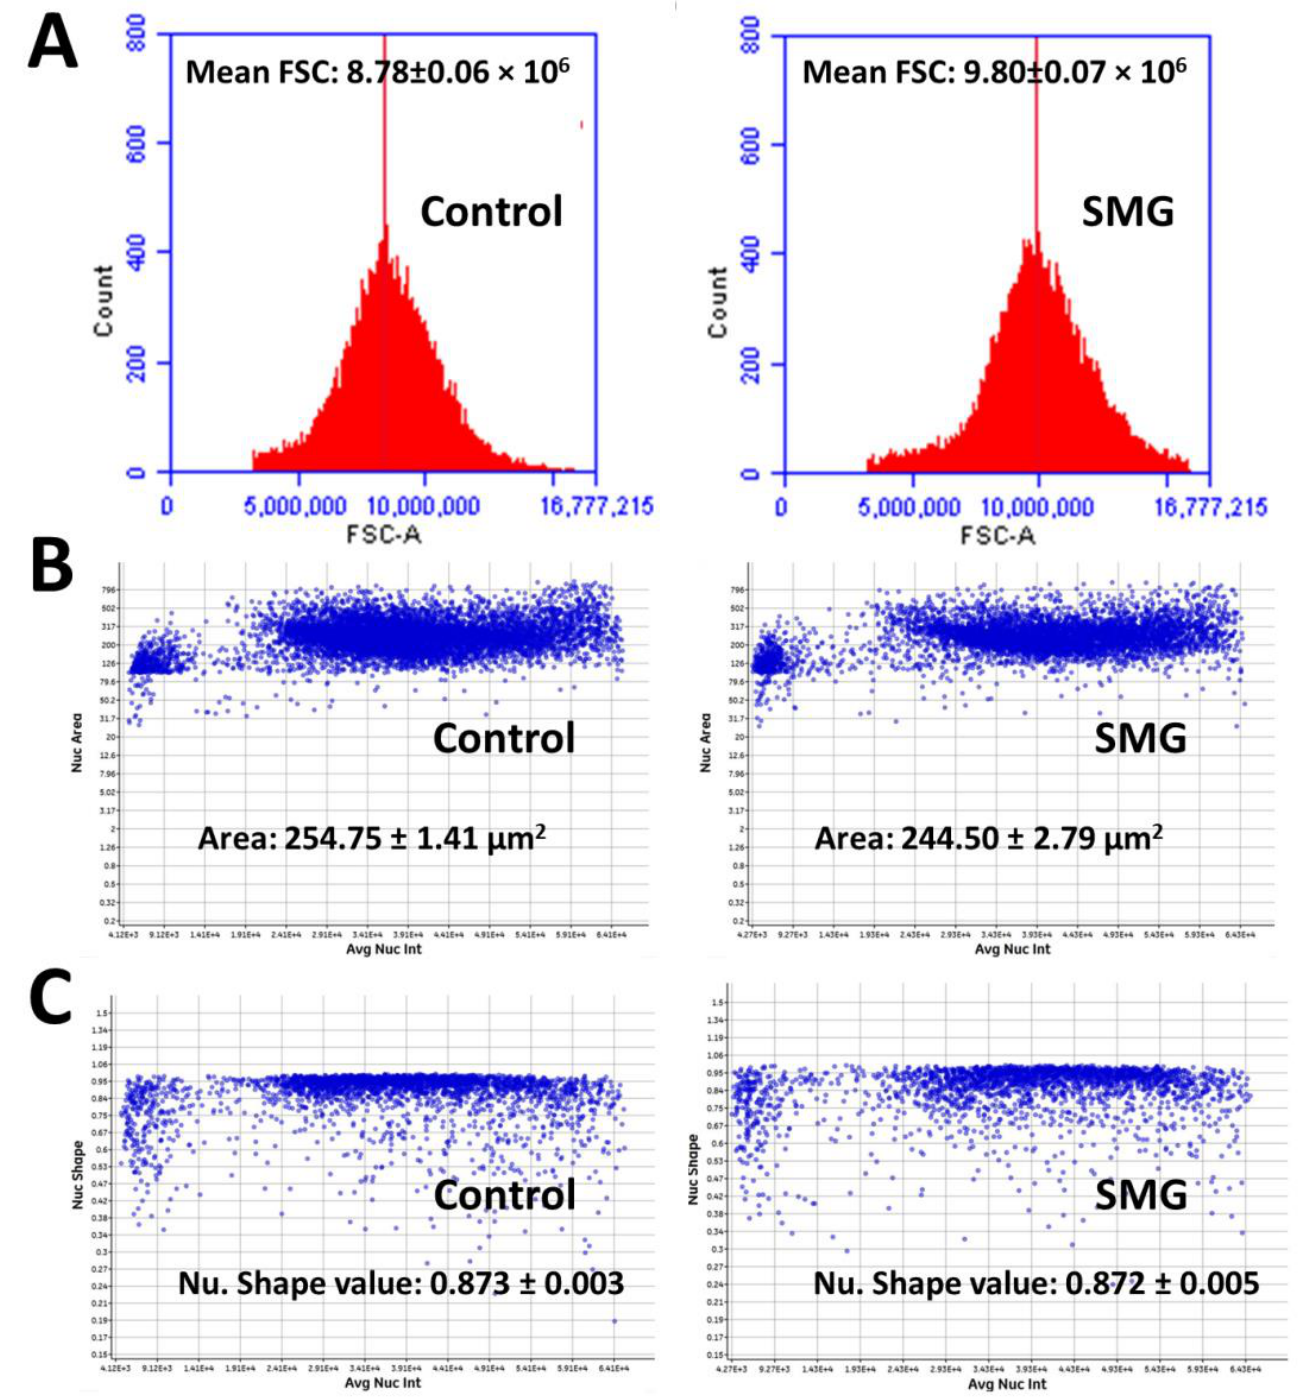
Figure 4. Morphology of CCL-13 cells. ( A ) The mean forward scatter (FSC) value indicates the diameter of CCL-13 cells ( n = 5). ( B ) The distribution of CCL-13 nuclear area in relation to the total nuclear intensity ( n = 12). ( C ) The distribution of nuclear shape value in relation to the total nuclear intensity ( n = 12).